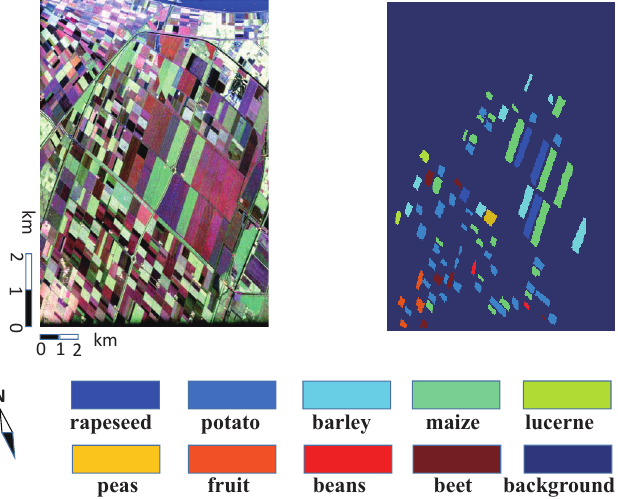
Figure 4. Flevoland II dataset: Pauli image (left) and ground truth image